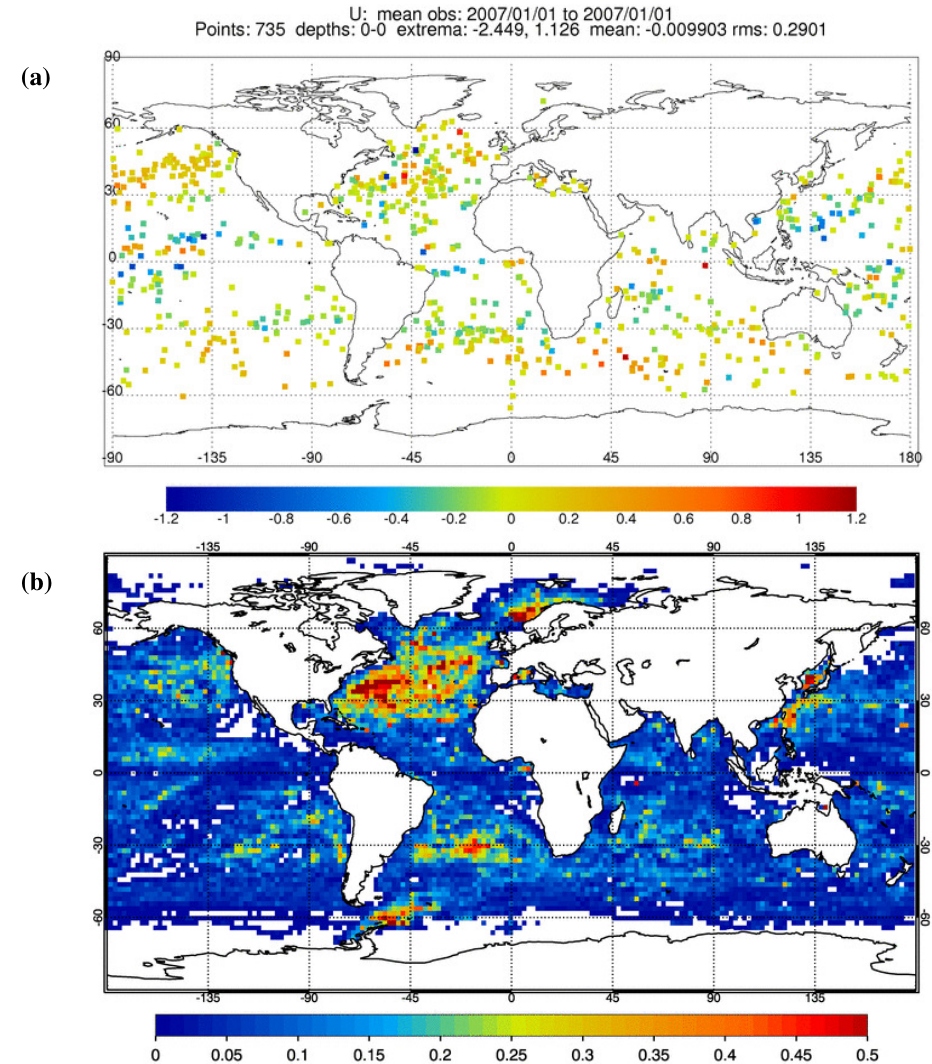
Fig. 1. The distribution of drifter-derived currents: (a) a typical daily distribution of velocity observations taken from 1 January 2007, (b) the average number of observations per day for the 2-yr period 2007–2008 in 2 ◦ bins.